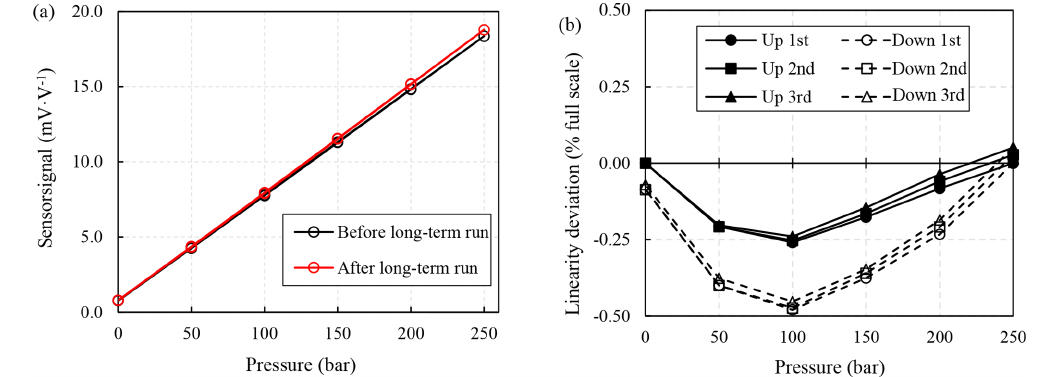
Figure 10. (a) Raw sensor output signal before and after the long-term run of the steel membrane, measured on the static test bench at 230 ◦ C. (b) Linearity deviation of the steel membrane sensor after the long-term run at 230 ◦